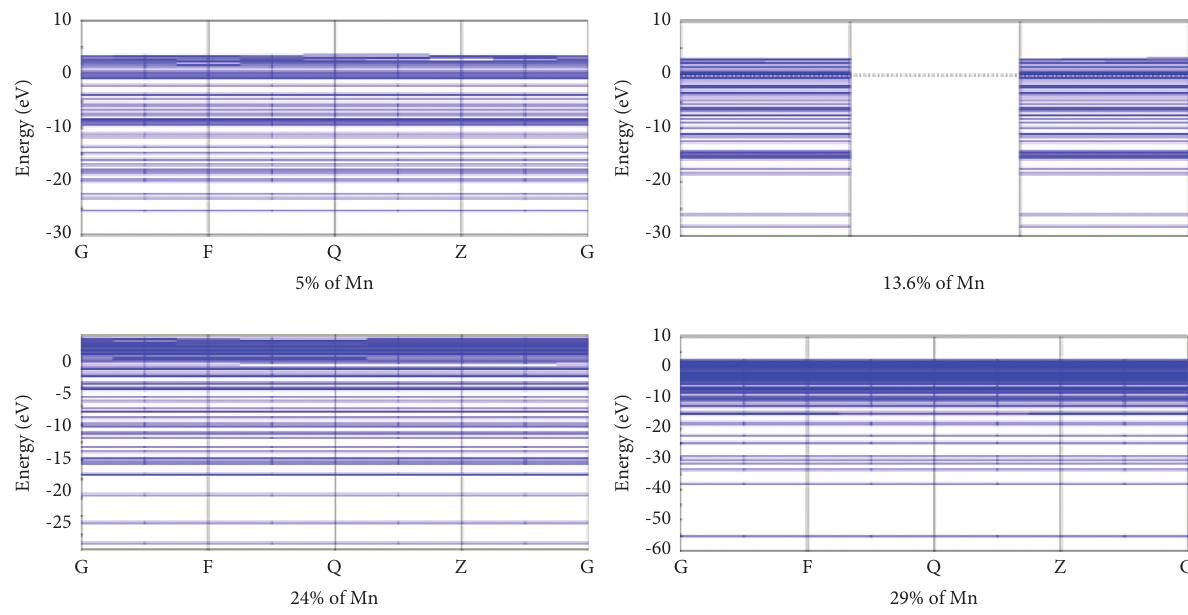
Figure 2: The band structure of InSb–Mn with Mn � 5%, Mn � 13.6%, Mn � 24%, and Mn � 29%.